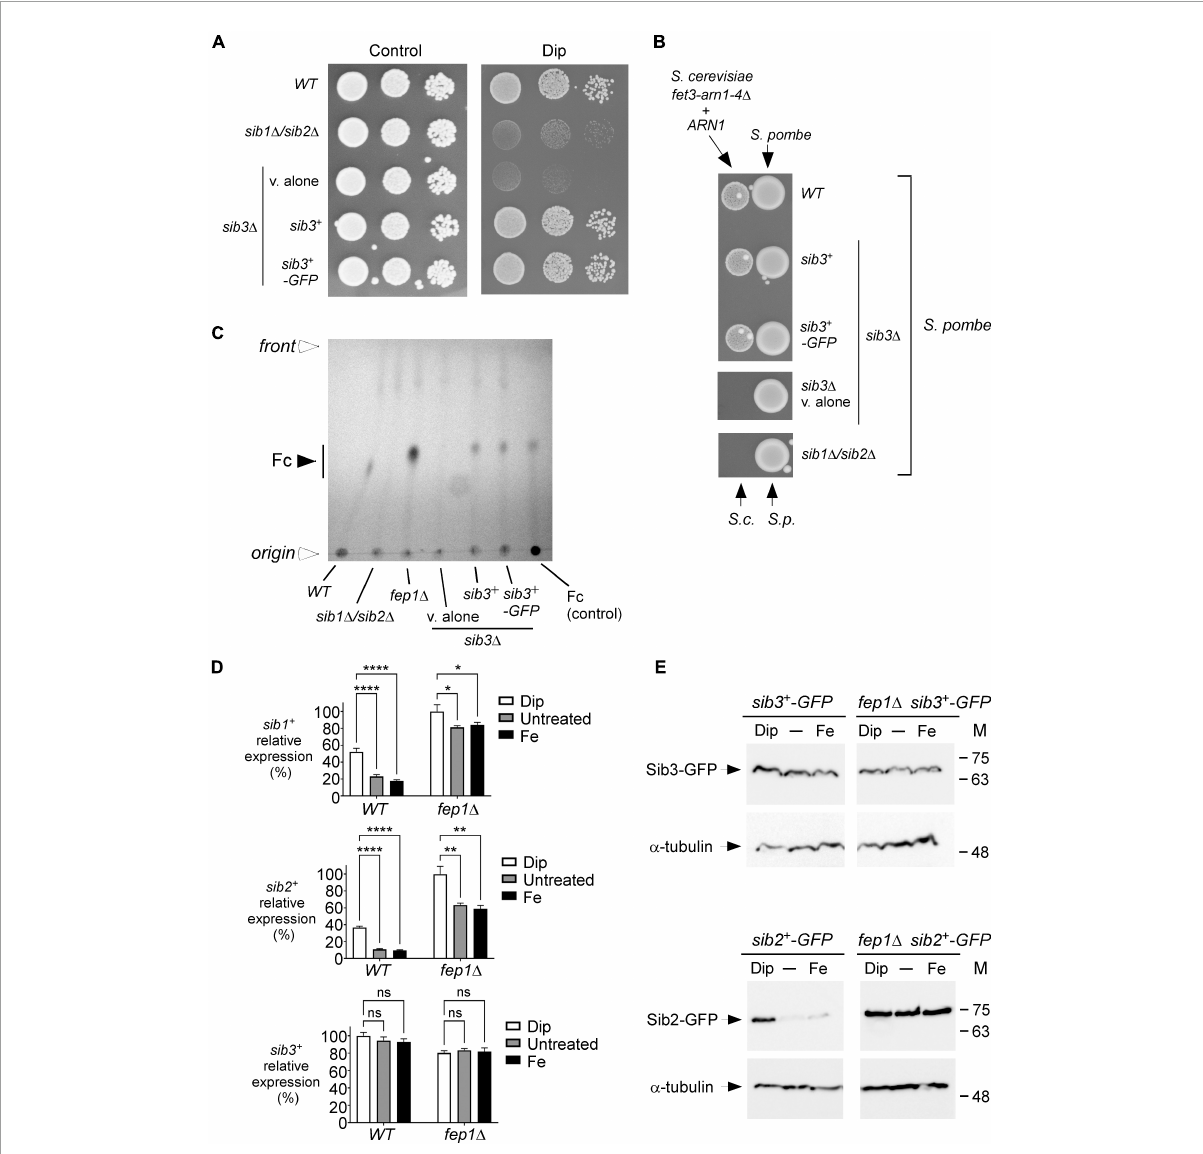
FIGURE4 S. pombe requires Sib3 to promote Fc-dependent growth of S. cerevisiae fet3 (cid:49) arn1-4 (cid:49) cells expressing ARN1. (A) Wild-type, sib1 (cid:49) sib2 (cid:49) , and sib3 (cid:49) strains were assayed for their ability to grow on YES medium containing 0 µ M (control) or 140 µ M Dip. In the case of the sib3 (cid:49) mutant, an empty plasmid (v. alone), sib3 + , or sib3 + -GFP allele was returned in the strain. Once spotted on the control and iron-starved media, the strains were incubated for 4 days at 30 ◦ C, and photographed. (B) The indicated S. pombe strains described in (A) were grown in the presence of iron (10 µ M) to an OD 600 of 1.0. Subsequently, these strains were inoculated (1 × 10 7 cells/10 µ l) (right side of each pair of spots) onto SD − Cu − Fe medium. S. cerevisiae fet3 (cid:49) arn1-4 (cid:49) cells expressing ARN1 were grown to the mid-logarithmic phase, diluted, and spotted (3,000 cells/10 µ L) in the vicinity of S. pombe strains (left side of each pair of spots). S.c., S. cerevisiae ; S.p., S. pombe . (C) The indicated S. pombe strains were grown to an OD 600 of 0.5 in YES medium and incubated in the presence of Dip (100 µ M) for 5 h. Total Fc was extracted and analyzed by TLC on silica gel sheets. Commercially purified Fc (15 µ g) (control) was loaded as a reference. Solid arrowhead indicates the migration position of Fc, whereas open arrowheads show the origin of sample loading and front of gel migration. (D) Shown are expression profiles of sib1 + , sib2 + , and sib3 + genes. Wild-type (WT) and fep1 (cid:49) strains were grown in YES medium and were either left untreated or treated with Dip (250 µ M) or FeCl 3 (Fe; 100 µ M) for 90 min. Total RNA was prepared from culture aliquots, and steady-state mRNA levels of sib1 + , sib2 + , and sib3 + were analyzed by RT-qPCR assays. Graphic representations of quantification of three independent RT-qPCR assays. Error bars indicate the standard deviation ( ± SD; error bars). The asterisks correspond to p < 0.05 (*), p < 0.01 (**), and p < 0.0001 (****) (two-way ANOVA with Tukey’s multiple comparisons test against the indicated strain grown under low-iron conditions), whereas ns stands for not significant. (E) A genetic approach was used for allowing homologous integration of the GFP coding sequence at the chromosomal loci of sib2 + and sib3 + , respectively, therefore creating strains containing GFP-tagged sib2 + and sib3 + alleles. Subsequently, these two strains were used for disrupting the fep1 + gene and generating sib2 + -GFP fep1 (cid:49) and sib3 + -GFP fep1 (cid:49) strains. All four S. pombe strains were left untreated (-) or treated with Dip or FeCl 3 (Fe), as described in (D) . Aliquots of whole cell extract preparations were analyzed by immunoblot assays using anti-GFP and anti- α -tubulin antibodies. The positions of the molecular weight standards (in kDa) are indicated on the right